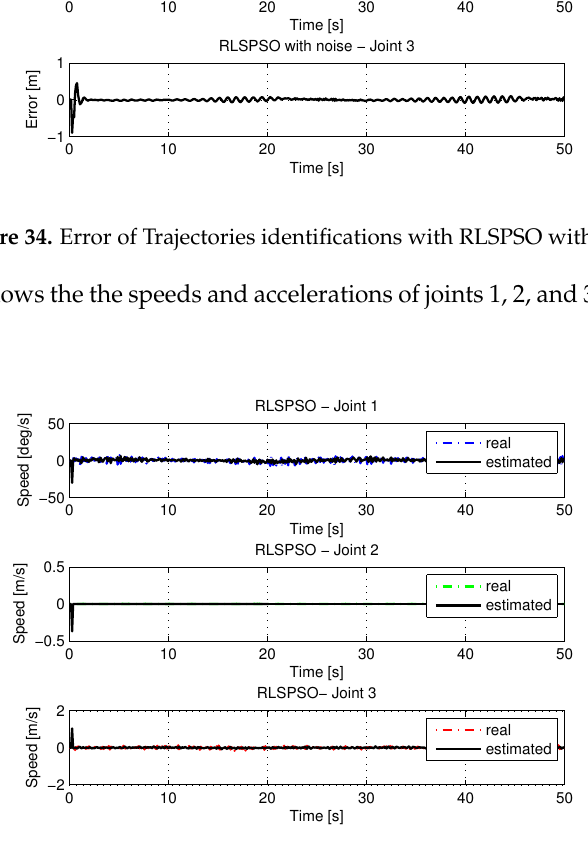
Figure 35. Speed of joints with RLSPSO with